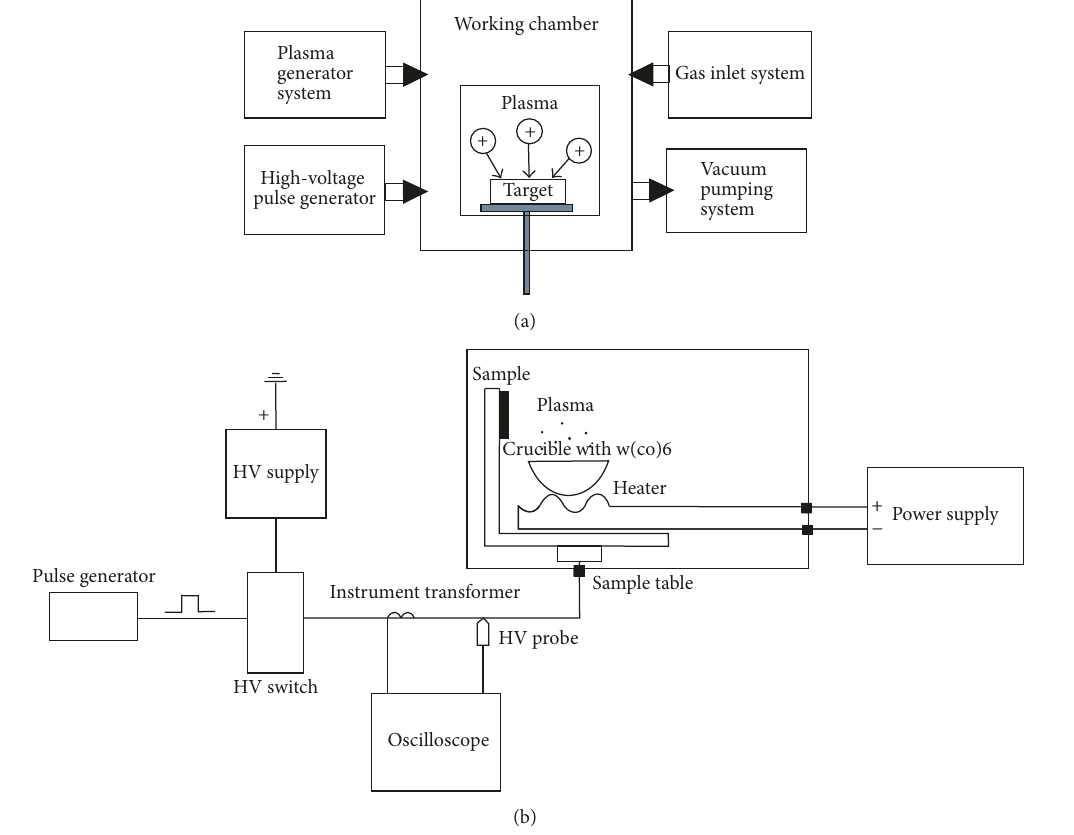
Figure 1: (a) Block diagram of PIII setup and (b) the setup modification for W